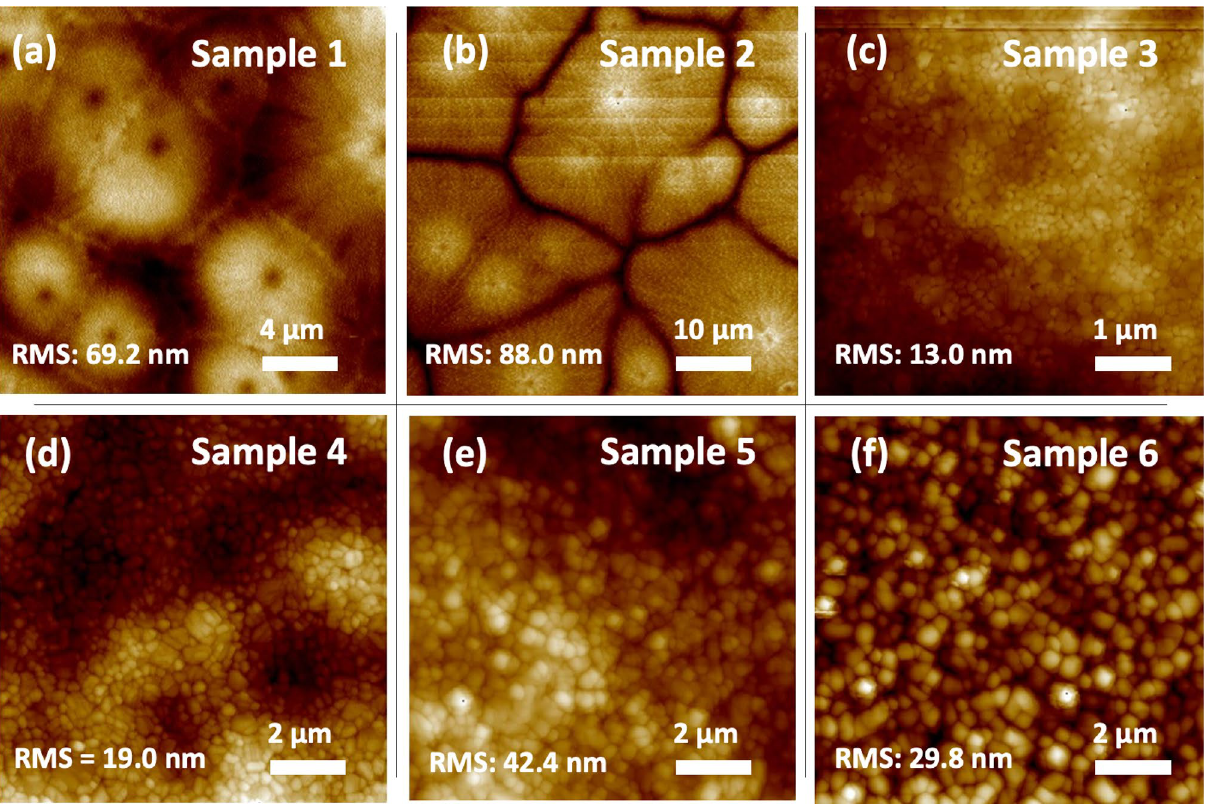
Figure 3. AFM images of MAPbI 3 thin films deposited on ITO substrates using the following methods: ( a ) ACN-based ink deposited on a hot substrate (sample 1); ( b ) ACN-based ink deposited on a hot substrate with N 2 blowing (sample 2); ( c ) ACN-based ink deposited on a hot substrate with N 2 blowing and MA-induced post- treatment (sample 3); ( d ) ACN-based ink deposited at room temperature with N 2 blowing (sample 4); ( e ) ACN/ NMP-based ink deposited at room temperature with an anti-solvent treatment (sample 5); ( f ) DMF/NMP-based ink deposited at room temperature with an anti-solvent treatment (sample 6).